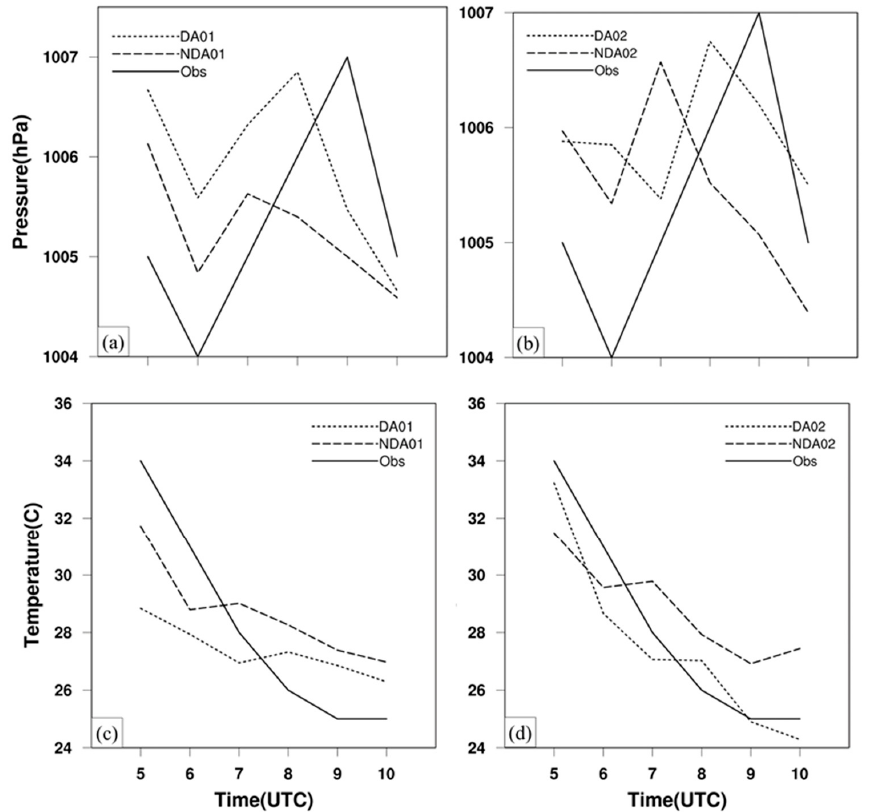
Figure 7. The hourly surface pressure for ( a ) observations (solid lines), DA01 (dot lines) and NDA01 (dashed lines) simulations, and for ( b ) observations (solid lines), DA02 (dot lines) and NDA02 (dashed lines) simulations of Pingtung Airport from 0500 to 1000 UTC (1300 to 1800 LST) on 5 August 2018. ( c , d ) are similar to ( a , b ), but for the hourly surface temperature. Note that Figure 7a,c are similar to Figure 6a,b, respectively, but different in the time span.